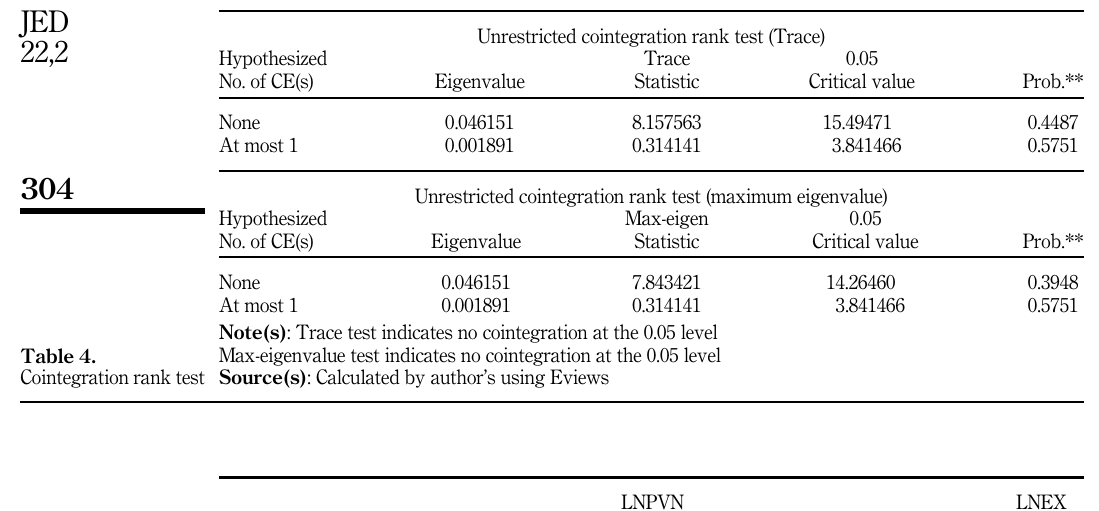
Table 5. Unrestricted vector autoregression estimates of PVN and